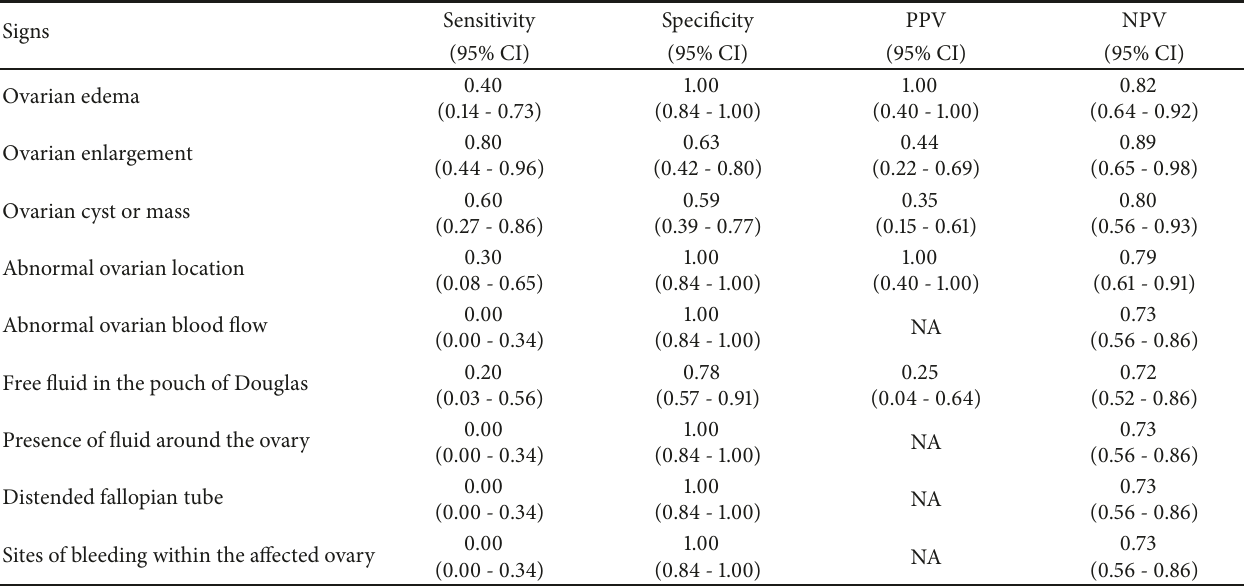
Table 4: The observed outcome of sensitivity, specificity, PPV, and NPV.